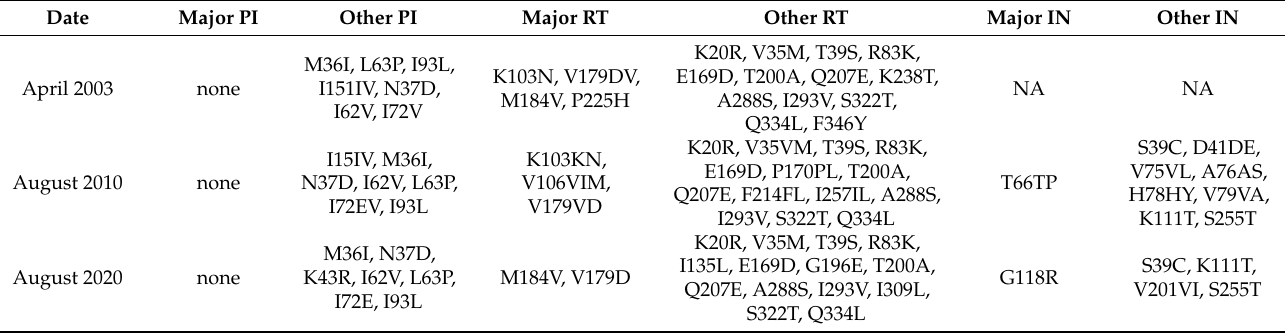
Figure 2. The evolution at site 118 of the integrase gene (highlighted in yellow) at nucleoside and amino acid level GGC (G) to AGA (R). Table 1. Results of genotypic drug resistance tests over the course of treatment.